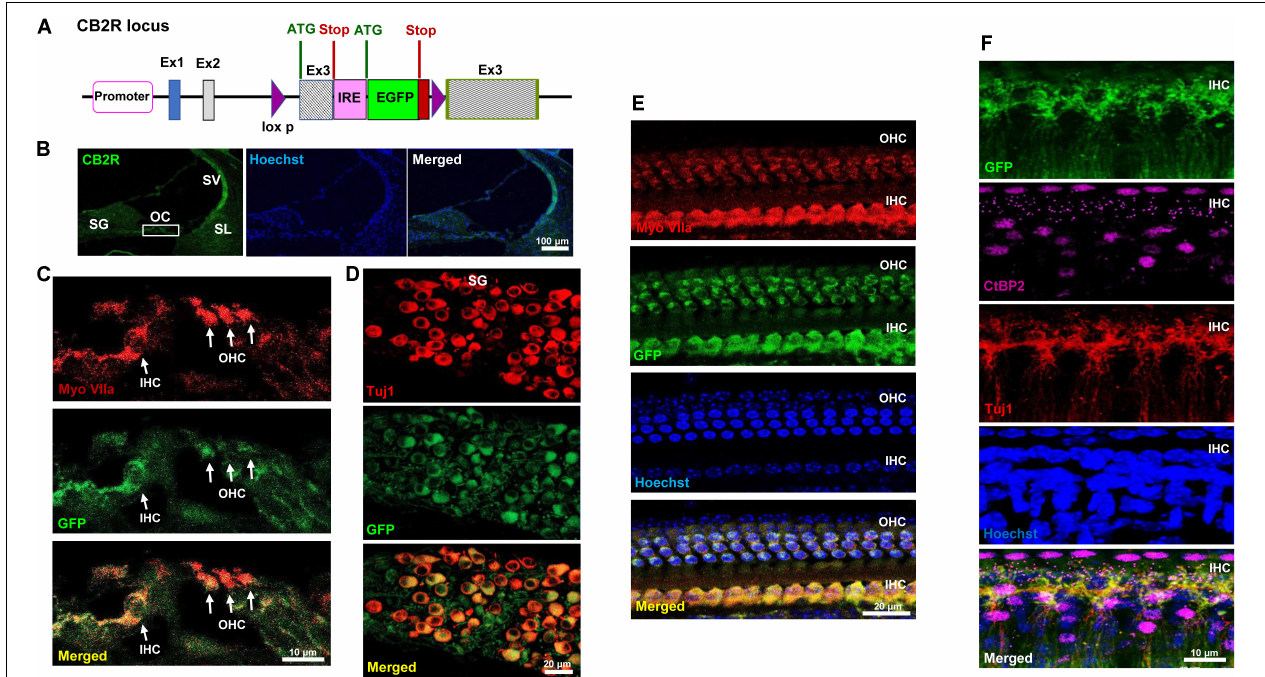
FIGURE 1 | Distribution of the GFP-tagged CB2R knock-in mice. (A) The genetic background of the knock-in mice is shown where the GFP reporter gene was inserted within exon 3 of CB2R and the expression of GFP was driven by internal ribosomal entry (IRE) promoter. Cochleae isolated from these GFP-CB2R co-expressing knock-in mice were fixed in 4% paraformaldehyde followed by decalcification and then sectioned. (B) The representative mid-modiolar section shows endogenous GFP fluorescence (green) in different anatomical regions of the cochlea including organ of Corti (OC), stria vascularis (SV), spiral ligament (SL), and spiral ganglion (SG) neuron. (C) Immunolabeling of GFP-tagged CB2R (green) along with hair cell marker, Myo VIIa (red), show colocalization of CB2R in both, the OHCs and IHCs. (D) Co-labeling of these cochleae with Tuj1 (red), a neuronal marker, show the distribution of GFP-CB2R (green) in spiral ganglion neurons. (E)